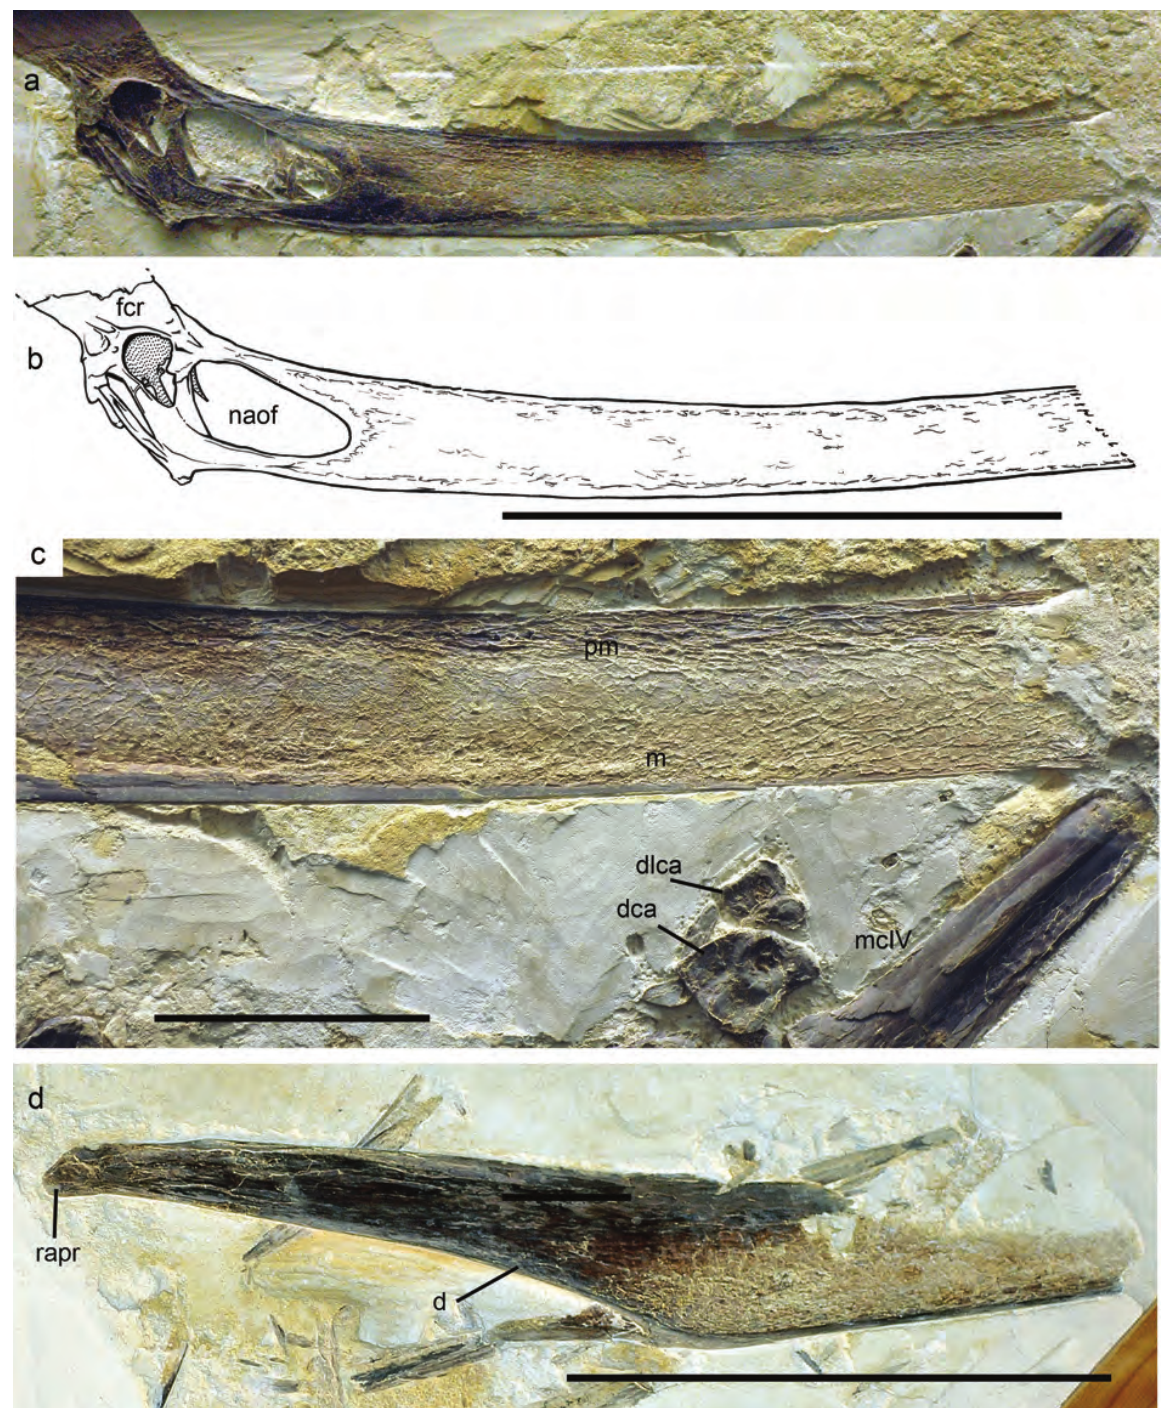
Fig. 2 – Dawndraco kanzai gen. et sp. nov., holotype (KUVP 27821). (a) photograph and (b) drawing of the complete skull; (c) detail of the preserved tip of the upper jaw; (d) lower jaw. Scale bars: a, b: 500 mm; c: 100 mm; d: 30